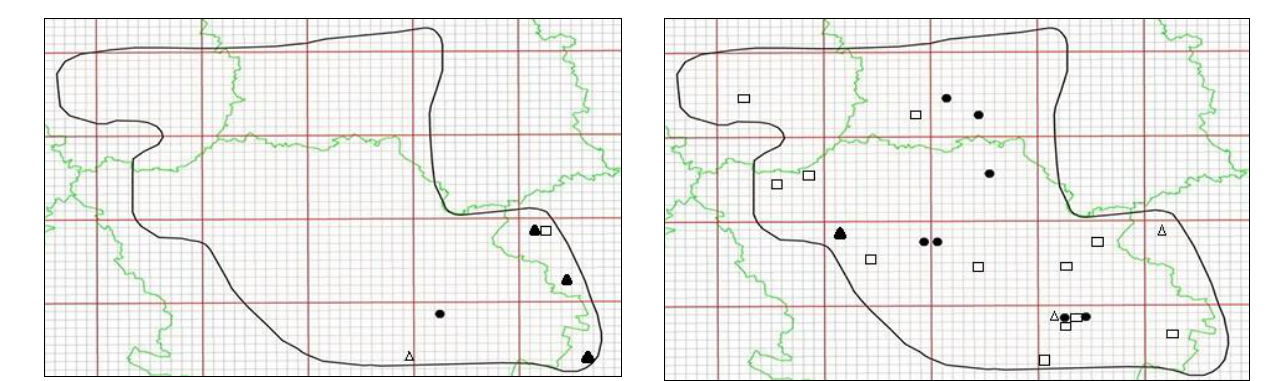
Fig. 3. The distribution of selected ephemerophytes in the Fig. 4. The distribution of selected ephemerophytes in the Romensko-Poltavsky Geobotanical District: A. - Gypsophila Romensko-Poltavsky Geobotanical District: A. - perfoliata L.; B. - Atriplex micrantha C.A. Mey; C. - Sisymbrium polymorphum (Murray) Roth; B. - Rumex Chenopodium × preissmannii J. Murr; D. - Chenopodium × longifolius DC.; C. - Malus sylvestris Mill.; D. thellungii J. Murr